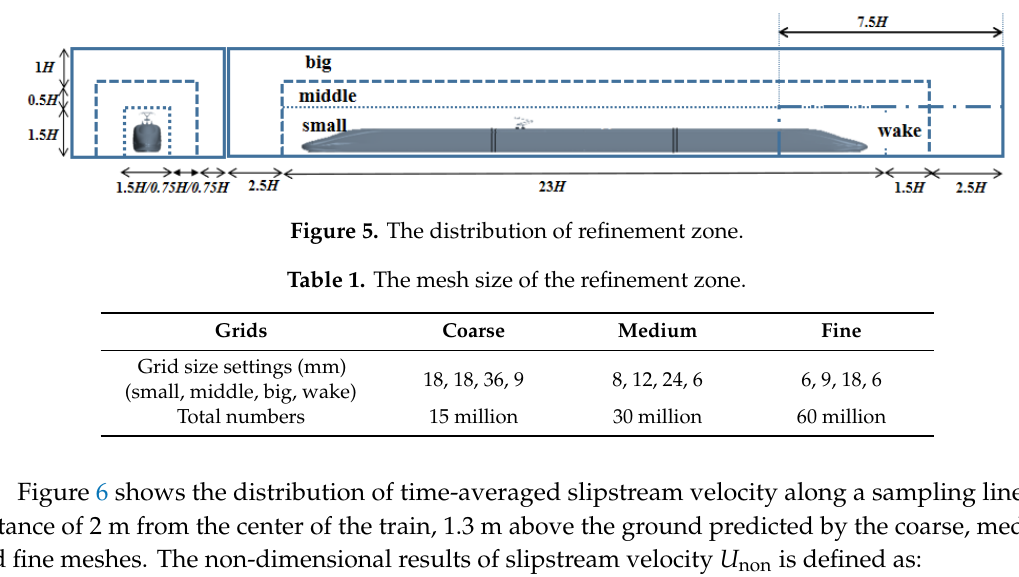
Figure 4. Locations of aerodynamic noise observers.